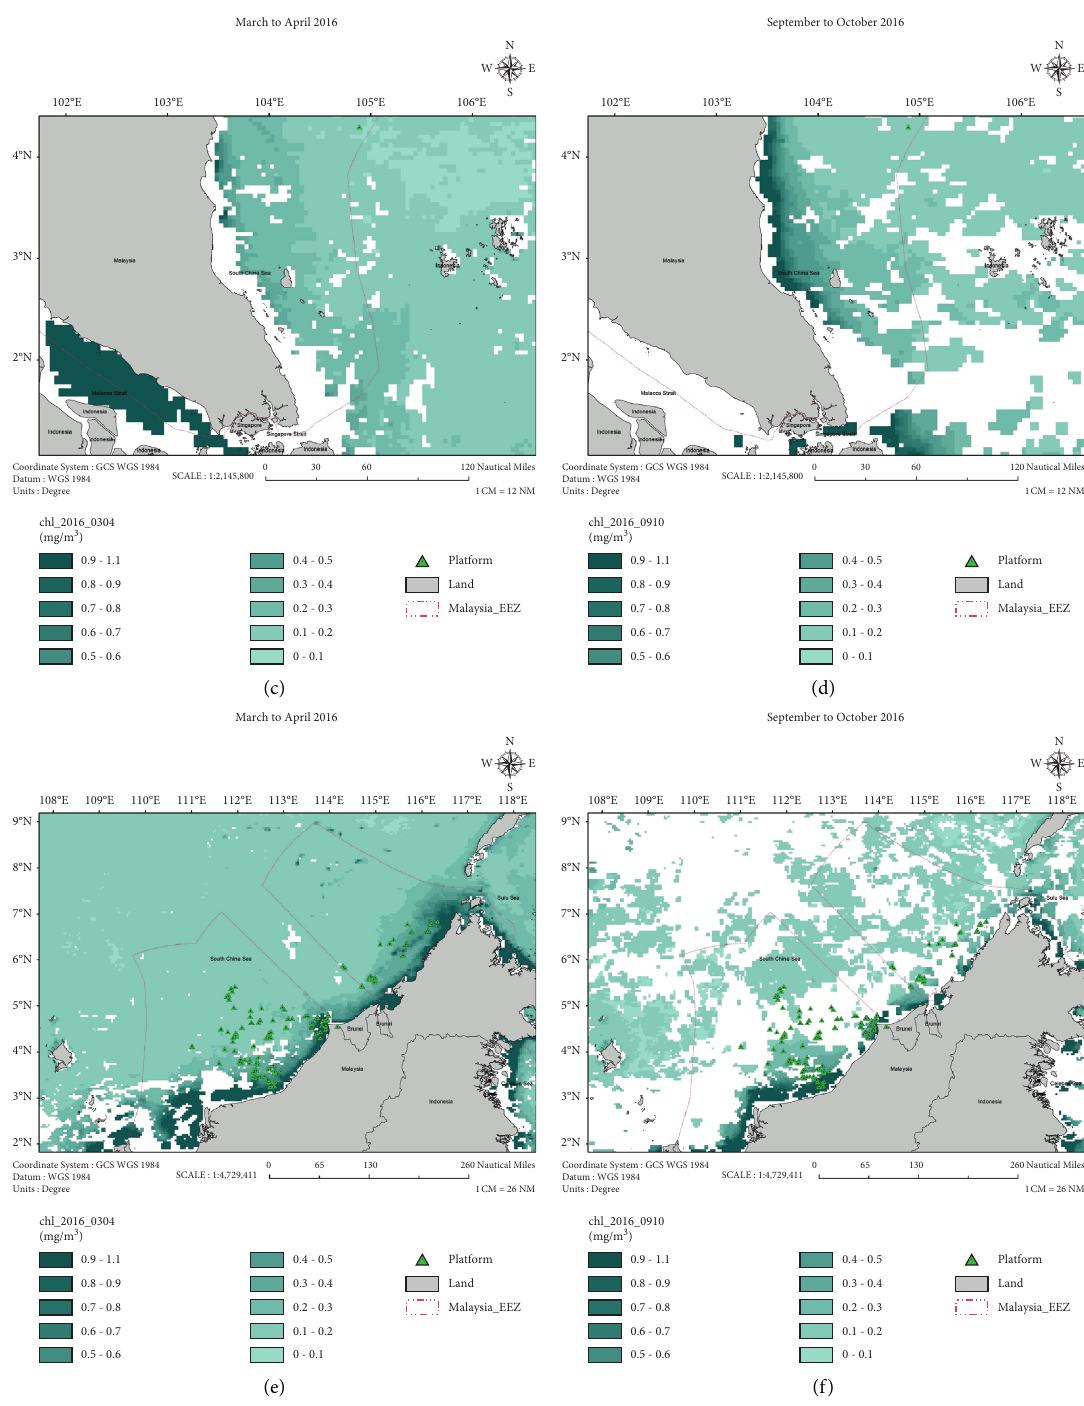
Figure 6: Chlorophyll-a content during September to October 2016. (a, b) North of Peninsular Malaysia. (c, d) South of Peninsular Malaysia. (e, f) Sabah and